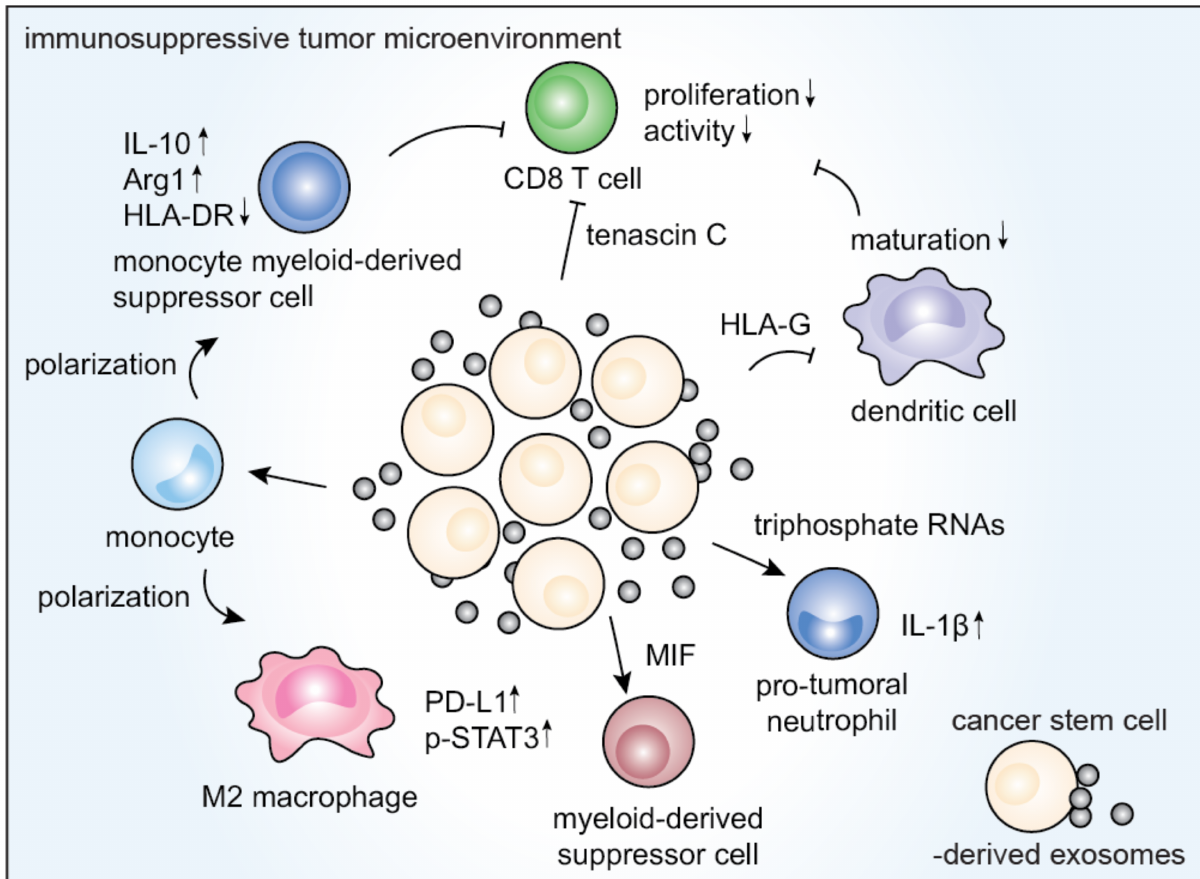
Figure 2. The involvement of CSCEXs in modulating tumor-infiltrating lymphocytes. CSCEXs are known to exhibit the inhibition of proliferation and activation of CD8 + T cells, dendritic cell maturation, as well as multiple immunosuppressive effects exerted on M2 macrophages, protumoral monocytes, and